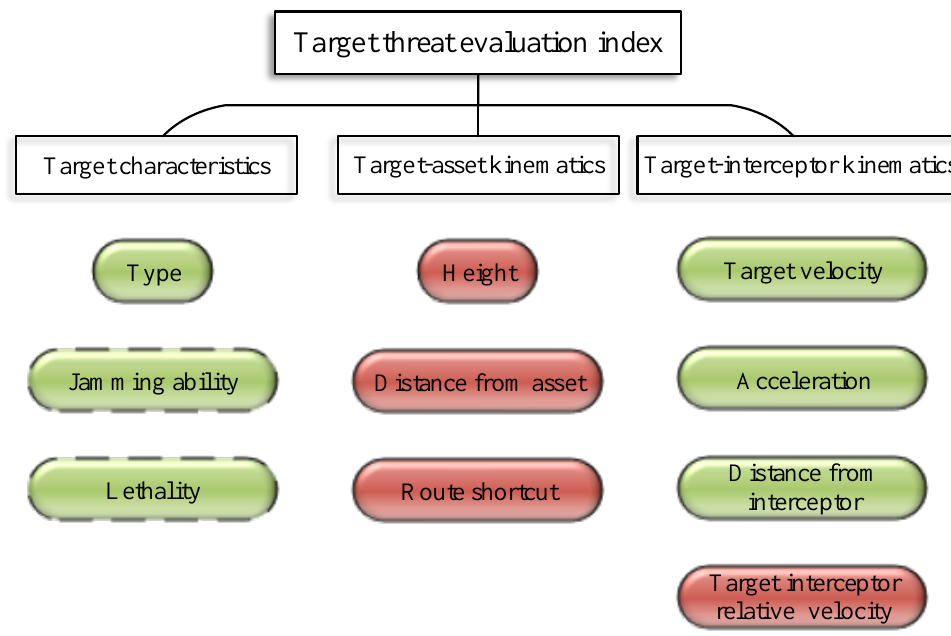
Figure 1. The evaluation index system of air target